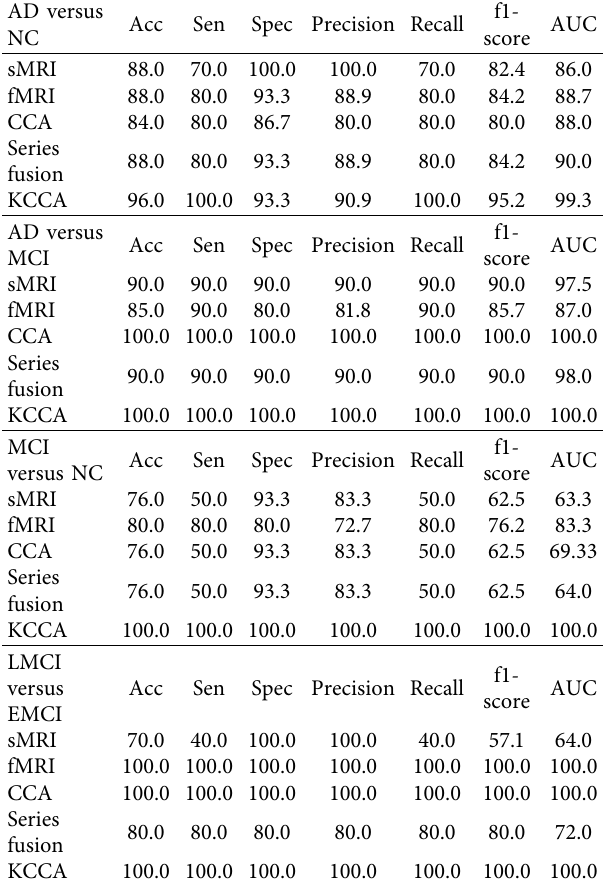
Table 5: Comparison results of three feature fusion methods and single-modal method